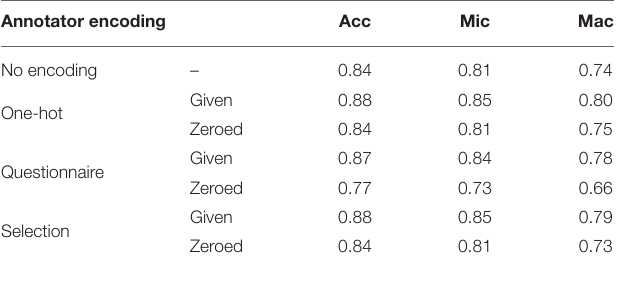
TABLE 11 | Performances on the aggregated test set after training on the aggregated training set with different annotator encodings, and with given or zeroed annotator encodings at prediction time.